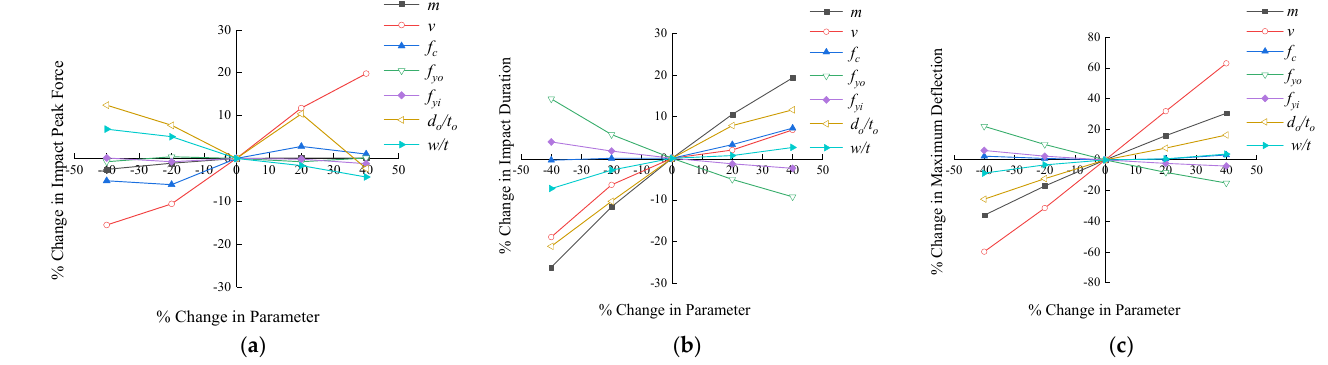
Figure 13. Sensitivity of S-ST corresponding to changes in structure-related variables. ( a ) Peak impact force; ( b ) Impact duration; ( c ) Maximum deflection.